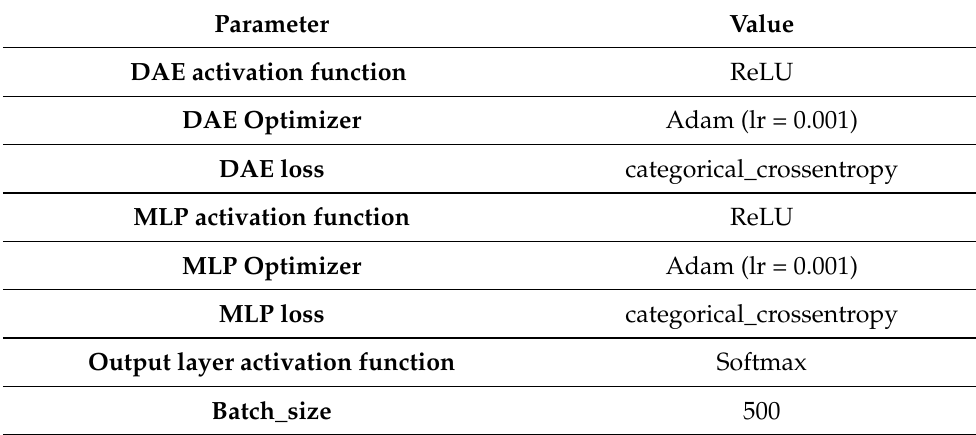
Table 1. Model parameter